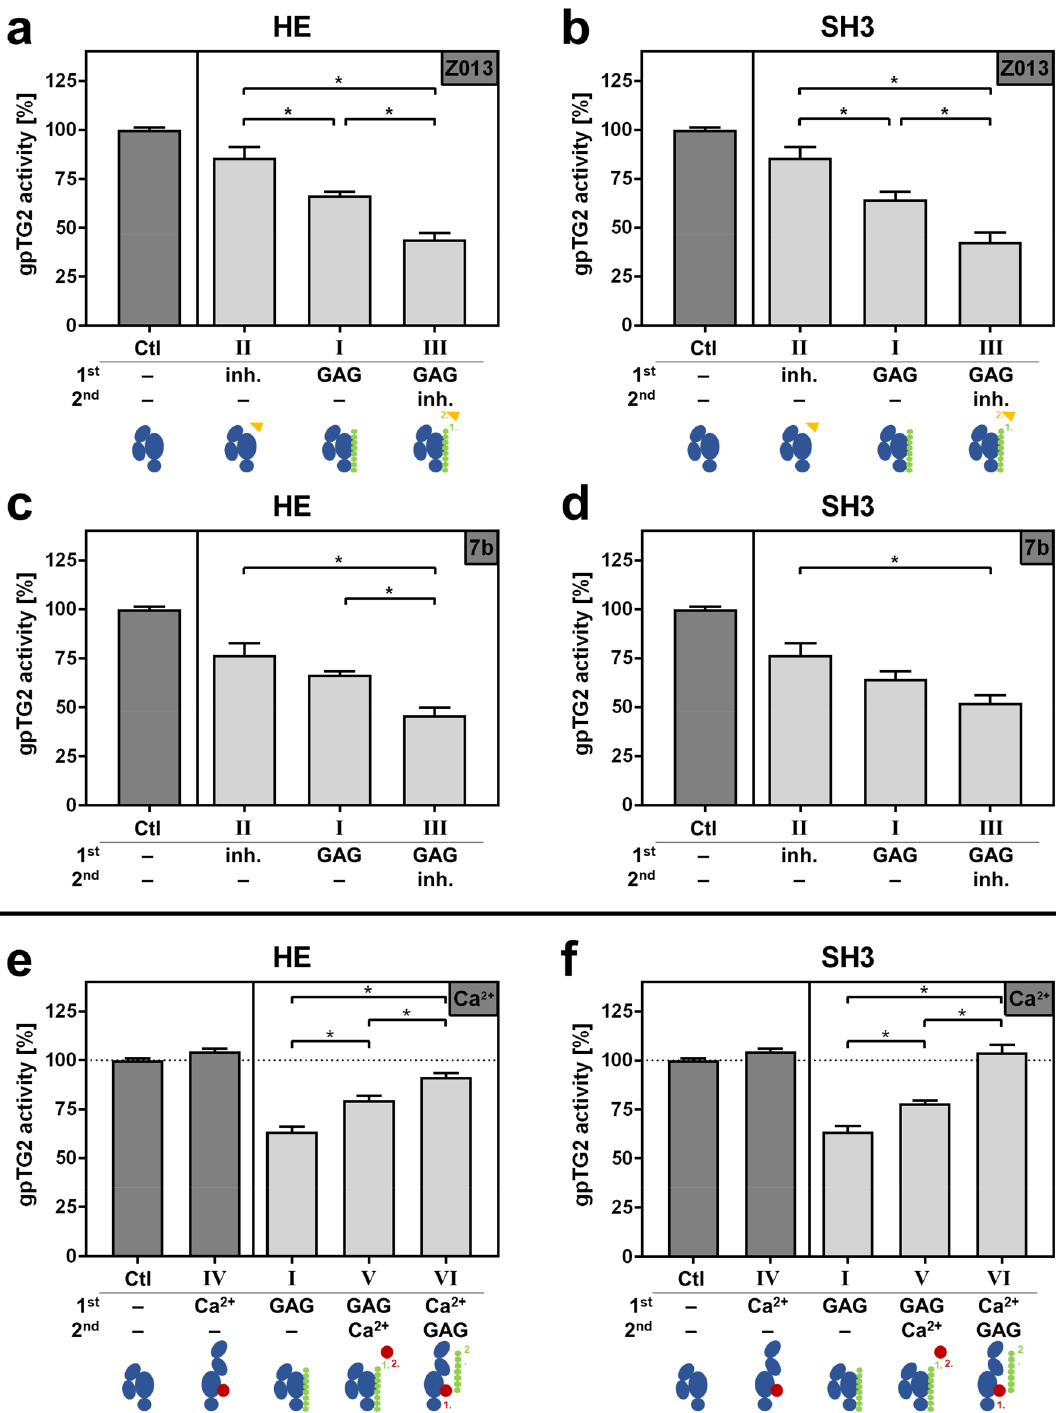
Figure 2. Influence of inhibiting or activating modifiers on the inhibitory effect of sulfated GAG derivatives. ( a – d ) Irreversible inhibitors: Before applying to the assay plate, gpTG2 was incubated according to experimental settings I–III with irreversible inhibitors Z013 and 7b , respectively (residual activity around 80%), and sulfated GAG derivatives ( a , c ) HE and ( b , d ) SH3, respectively (residual activity around 65%). Positive control “Ctl” (gpTG2 without any treatment) was set to 100%. ( e , f ) Ca 2+ activation: gpTG2 was incubated according to experimental settings I (residual gpTG2 activity around 65%) and IV–VI with 5 mM CaCl 2 and ( e ) HE or ( f ) SH3. The given Ca 2+ concentration refers to that one in the reaction tube before the mixture was applied to the assay plate and assay buffer (with Ca 2+ in excess) was added. Positive controls “Ctl” (gpTG2 without any treatment for “I”, “IV” and “V”; highlighted with a dotted line) and “IV” (gpTG2 activated with 5 mM CaCl 2 concentration for “VI”) were set to 100%. Values in all panels are shown as mean ± SEM; n = 3. Significant differences (p < 0.05) between settings I–III ( a – d ) or I, V and VI ( e , f ) were calculated by one-way ANOVA and Bonferroni’s post-test and are indicated with